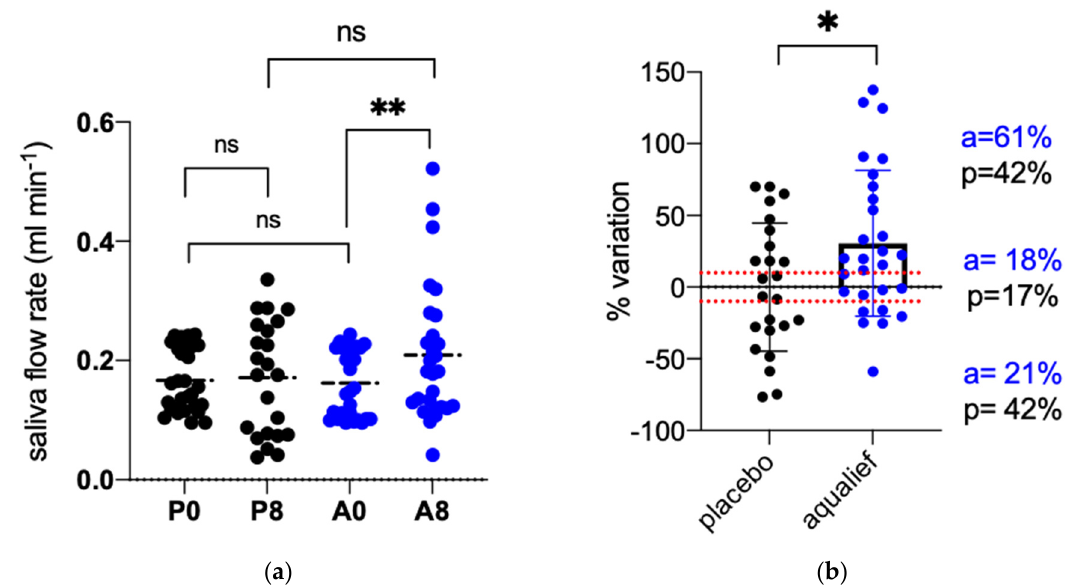
Figure 1. Effect of Placebo and Aqualief TM on salivation. ( a ) Saliva flow rate (mL min − 1 ) recorded before (P0,A0) and after 7 days of treatment (P8,A8); ( b ) Data are reported as percent variation of saliva flow rate between the two time points. P, placebo, A, Aqualief TM , * p < 0.1, ** p < 0.01. Statistical analysis between the two time points of the same group was performed by paired t -test, between the two groups by unpaired t -test.